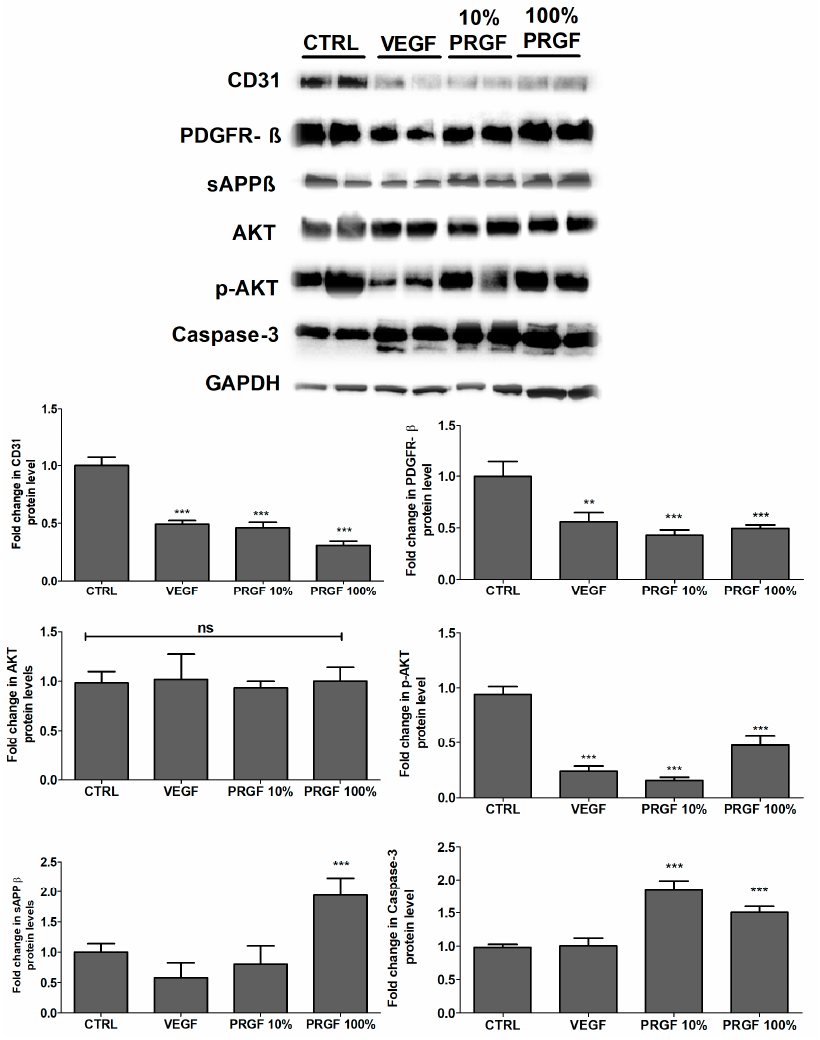
Figure 6. Effect of VEGF (100 pg/mL) and PRGF (10 and 100%) treatments on angiogenesis and apoptosis markers, and on amyloid production in 5xFAD mice brains. Representative blots and densitometry analysis of PDGF-R- β , CD31, Akt, p-Akt, caspase-3 and sAPP β in mice brain homogenates. Data are presented as mean ± SEM ( n = 7 mice/group). ** p < 0.01, *** p < 0.001 compared to control (CTRL) group; ns is not